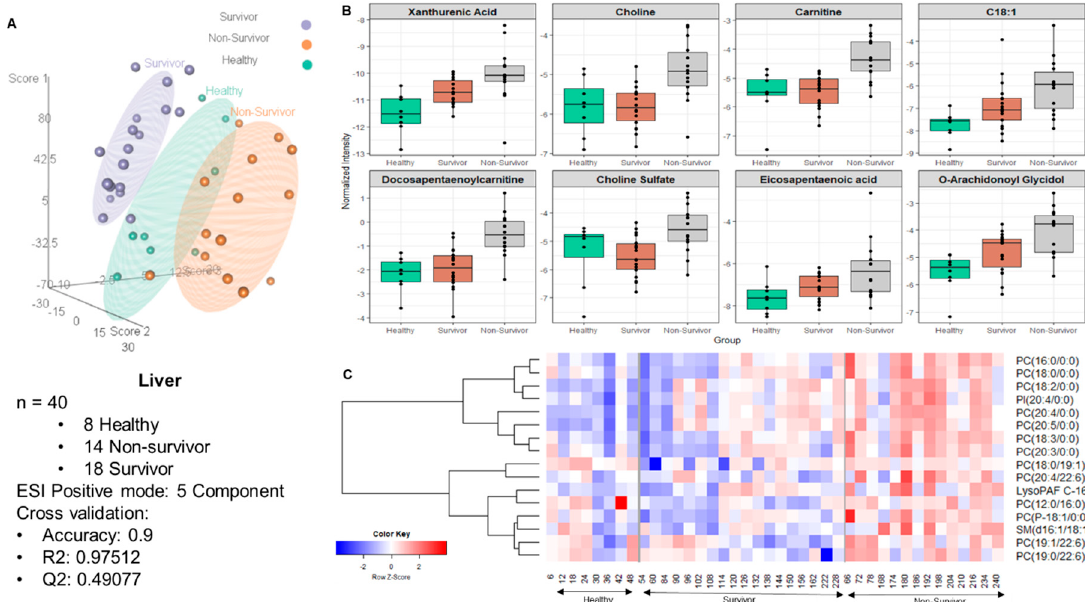
Figure 2. Exposure to ionizing radiation leads to robust changes in liver metabolomic and lipidomic profiles. Panel ( A ): Three dimensional PLS-DA plot showing separation of healthy NHPs (N = 8) from those who either survived (N = 18) or succumbed to radiation-induced (N = 14) tissue injury within 60 days. The prediction accuracy for 100 permutations yielded a p-value of 0.04. Panels ( B and C ): Relative abundance of significantly dysregulated metabolites and lipids in the three study groups, respectively.